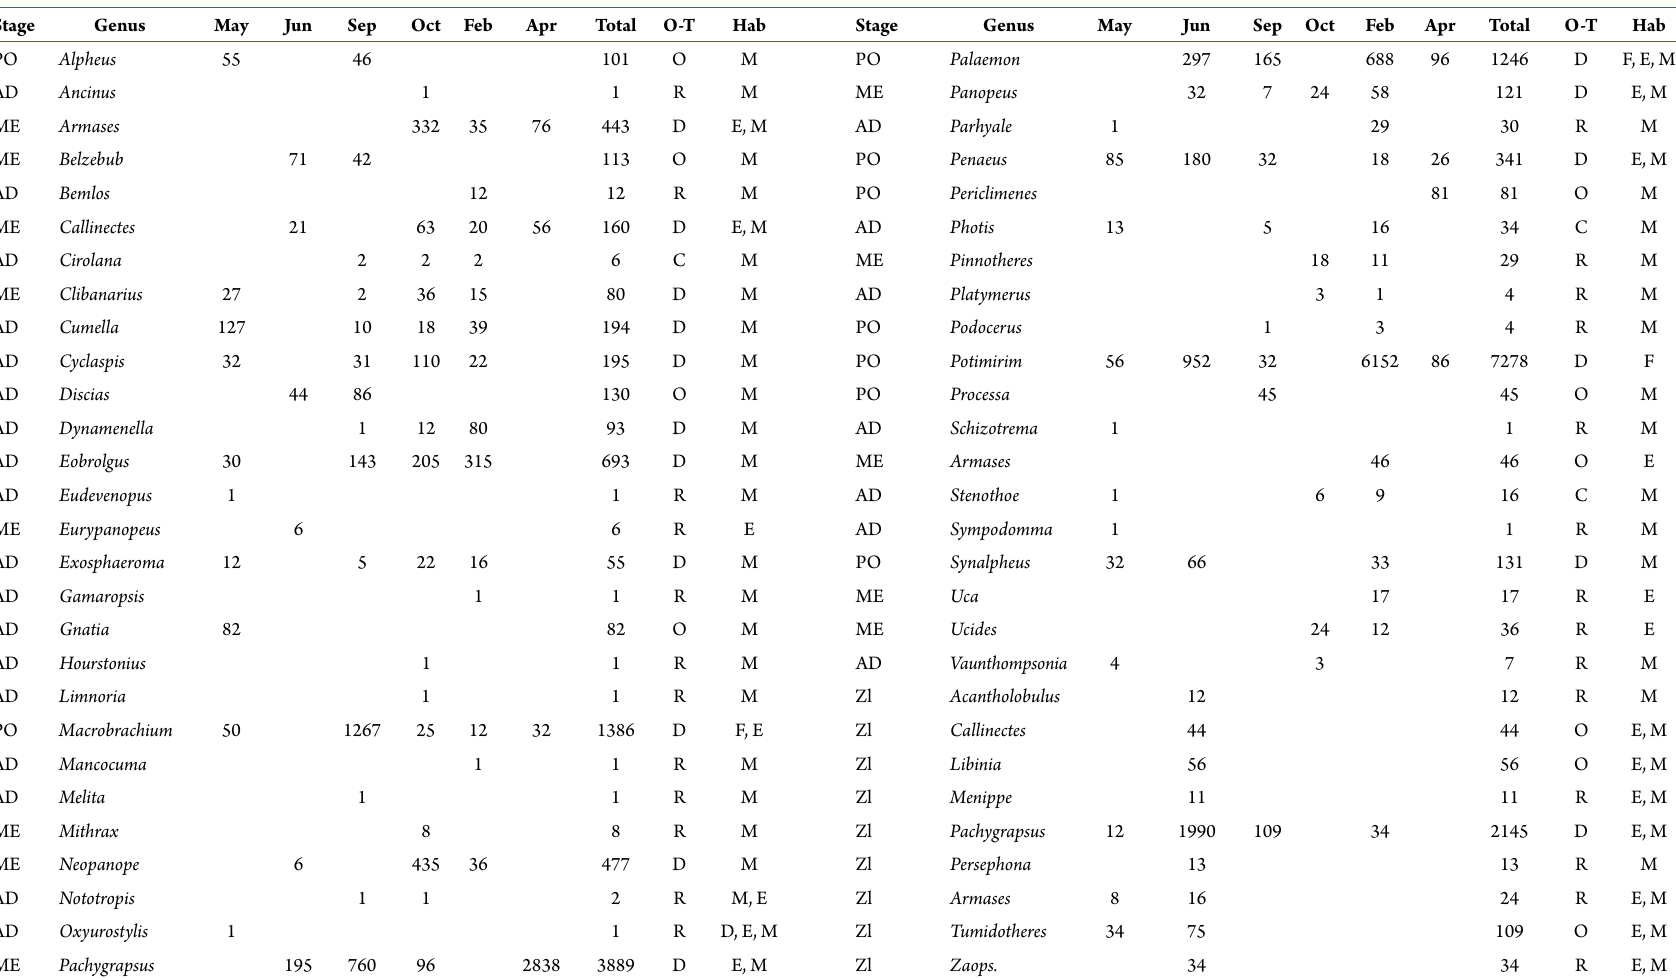
Table 4. Abundance of larvae and macro-crustaceans in six months of sampling on the coastline of the Parque Nacional Sistema Arrecifal Veracruzano. AD, adult; D, dominant; E, estuarine; F, freshwater; Hab, habitat; M, marine; ME, megalopa; O, occasional; O-T, Olmstead-Tukey; PO, postlarva; R, rare; Z1, zoea